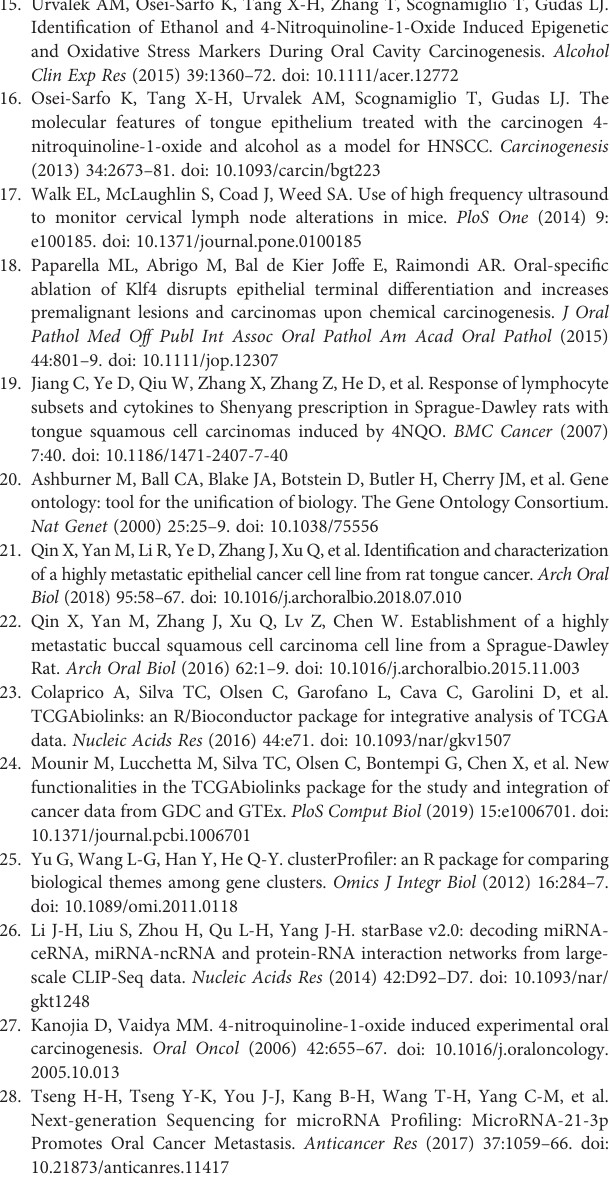
Supplementary Figure 1 | Bioinformatic analysis of miRNA and mRNA microarray. (A) The relative expression level of Ubadc1, Ldhb, Cabc1 in SD rat tongue SCC. (B) The relative expression level of miR-30c-5p, miR-30d-5p, miR- 30e-3p in SD rat tongue SCC. (C) MicroRNA-gene-network. Red box nodes represent microRNA, and grey cycle nodes represent mRNA. Edges describe the inhibitiveeffectofmicroRNAonmRNA. (D) MicroRNA-GO-network.Redboxnodes represent microRNA, and grey cycle nodes represent GO. Edges describe the effect of microRNA on GO. (** p <0.01, *** p <0.001, **** p <0.0001). Supplementary Figure 2 | Possible target genes of miR-30b-5p or miR-30e-5p in HNSCC. (A) The relative expression level of possible target genes in HN4 after transfection with miR-30b-5p mimic or inhibitor. (B) The relative expression level of target genes in HN4 after transfection with miR-30e-5p mimic or inhibitor. (C – E) Correlationbetween miR-30b-5p and predicted possible genesinHNSCC samples of TCGA. (F – H) Correlation between miR-30e-5p and predicted possible genes